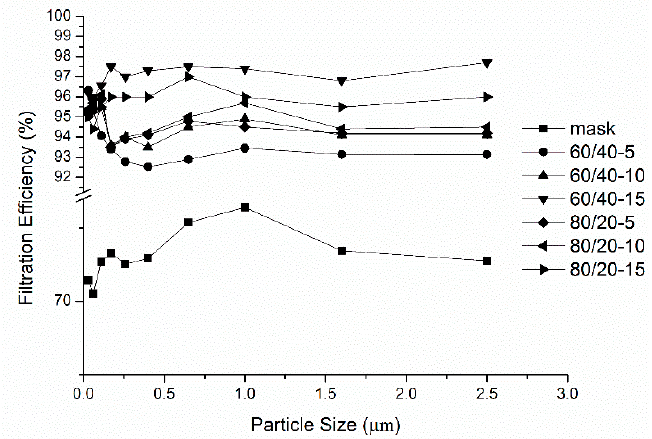
Figure 7. Filtration efficiency of PVA/WS-CS nanofibrous membranes as related to the particle size.